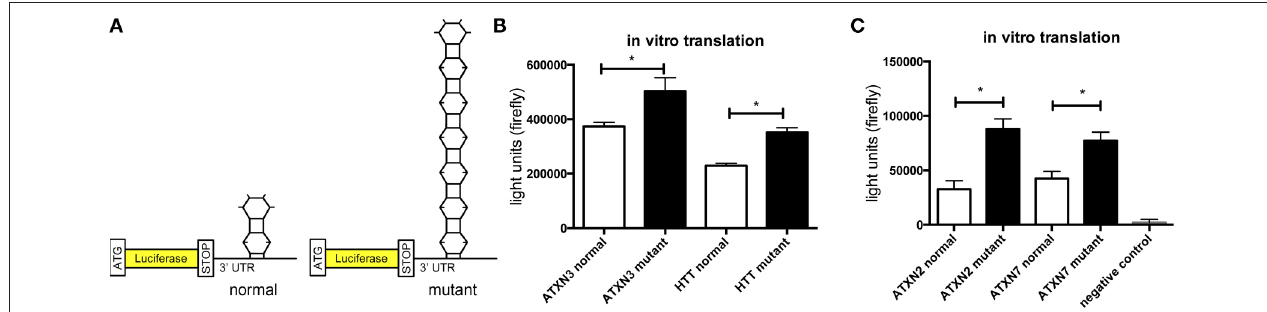
FIGURE 2 | Increased translation of ATXN2 , ATXN3 , and ATXN7 constructs with expanded CAG repeats in vitro . (A) Schematic showing luciferase reporter constructs used in this experiment. Luciferase reporter constructs were cloned that contain the CAG repeat region of ATXN2 , ATXN3 , and ATXN7 in the 3 ′ UTR. Two constructs each with either normal (left) or mutant CAG (right) repeat lengths were cloned. (B) In vitro translation of the luciferase reporters of ATXN3 . Previously published HTT exon1 luciferase reporter constructs were included as positive controls (Krauss et al., 2013). The constructs with either normal or mutant CAG repeat lengths were in vitro transcribed and equimolar amounts of RNA were subjected to in vitro translation. The level of translated luciferase reporter was measured in a luciferase assay. Columns represent mean values ± SEM. n = 3, p ≤ 0.01. (C) In vitro translation of the luciferase reporters of ATXN2 and ATXN7 . The constructs with either normal or mutant CAG repeat lengths were in vitro transcribed and equimolar amounts of RNA were subjected to in vitro translation. The level of translated luciferase reporter was measured in a luciferase assay. As a negative control, a sample without RNA was included. Columns represent mean values ± SEM. n = 3, p ≤ 0.0001. *Indicates statistically significant differences ( p <